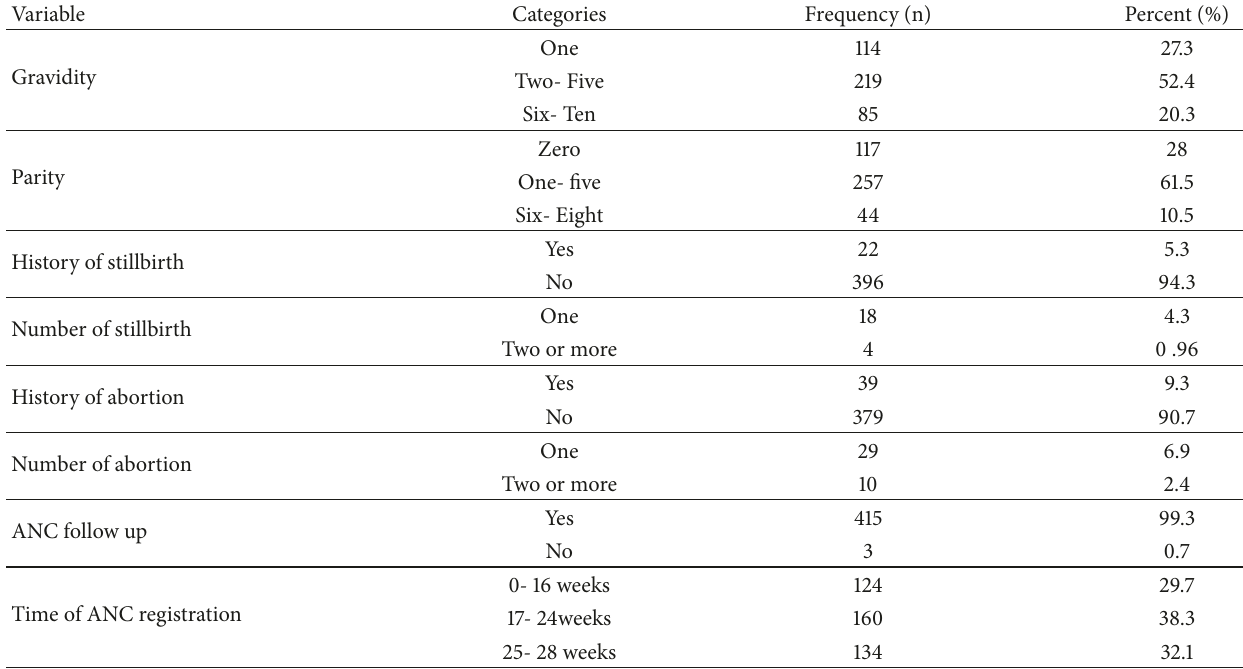
Table 2: Pregnancy, obstetric, and health-related factors of respondents, Lay Armachiho district Health Centers, Northwest Ethiopia, 2017